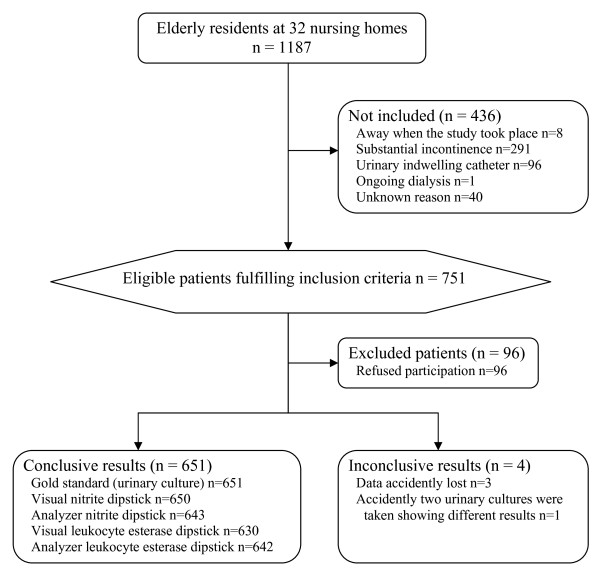
Participants flow chart.